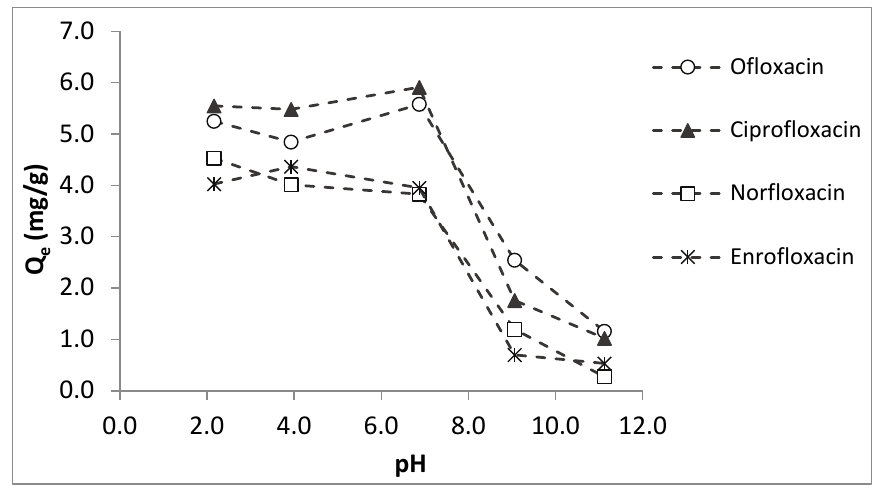
Figure 3. Effects of pH on fluoroquinolone sorption by colemanite (error bars are not shown for clarity).